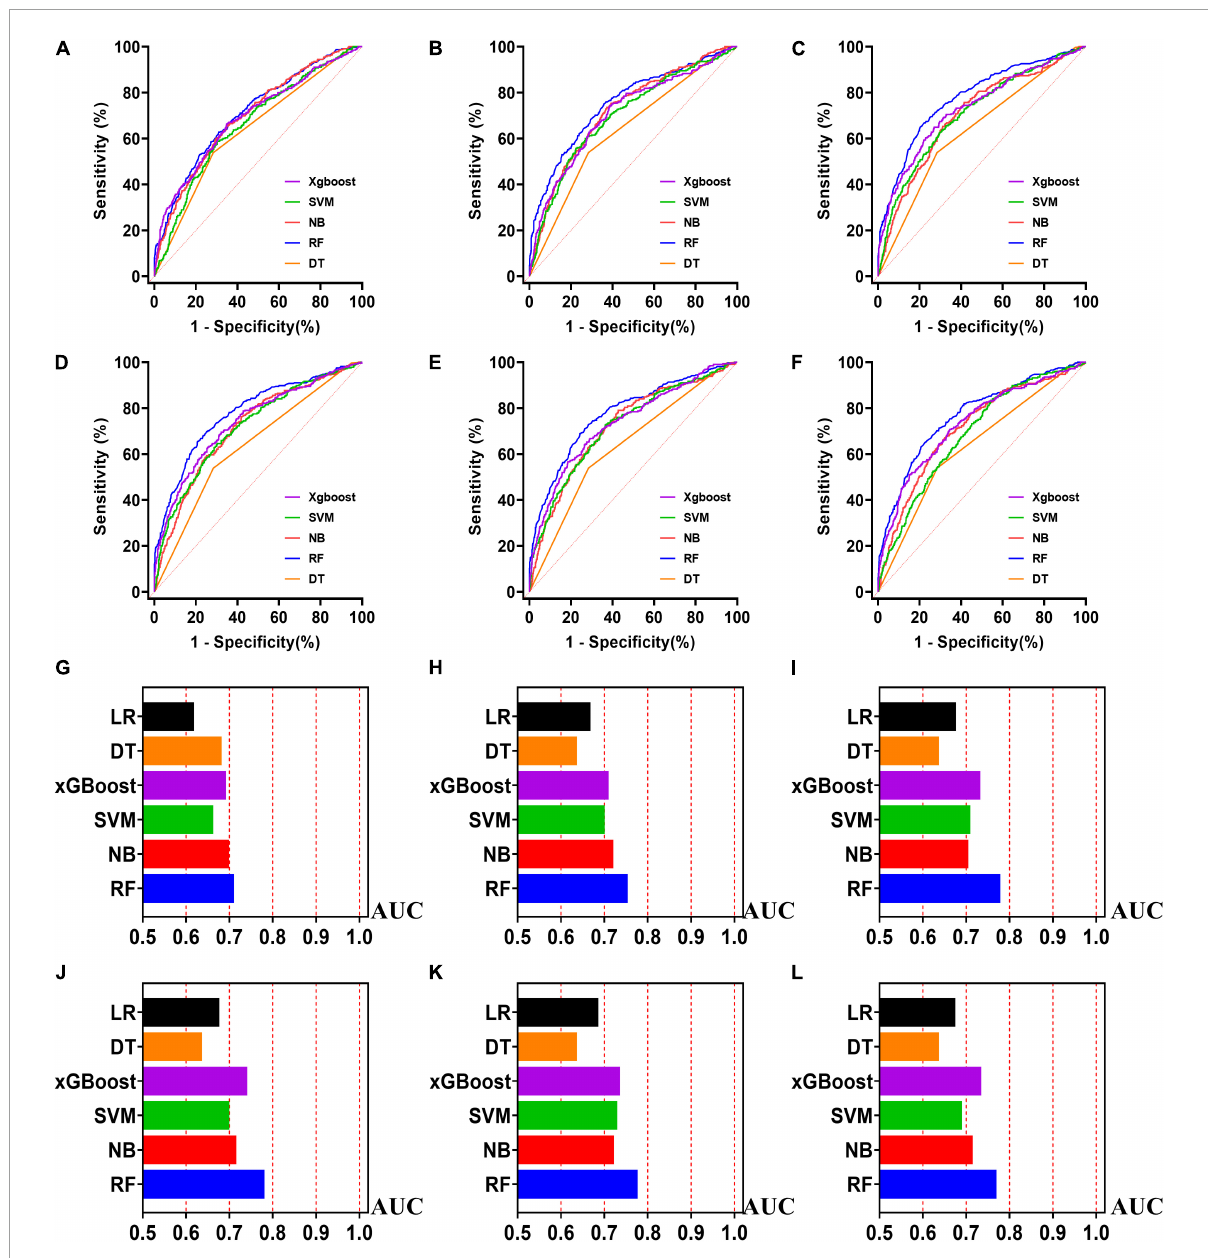
FIGURE5 The ROC curves for machine learning models and the performances of all models in validation cohort. The X-axis in 5G-5L represents the AUC values of each model. Top 5 variables (A,G) ; top 10 variables (B,H) ; top 15 variables (C,I) ; top 20 variables (D,J) ; top 25 variables (E,K) ; models for all variables (F,L)